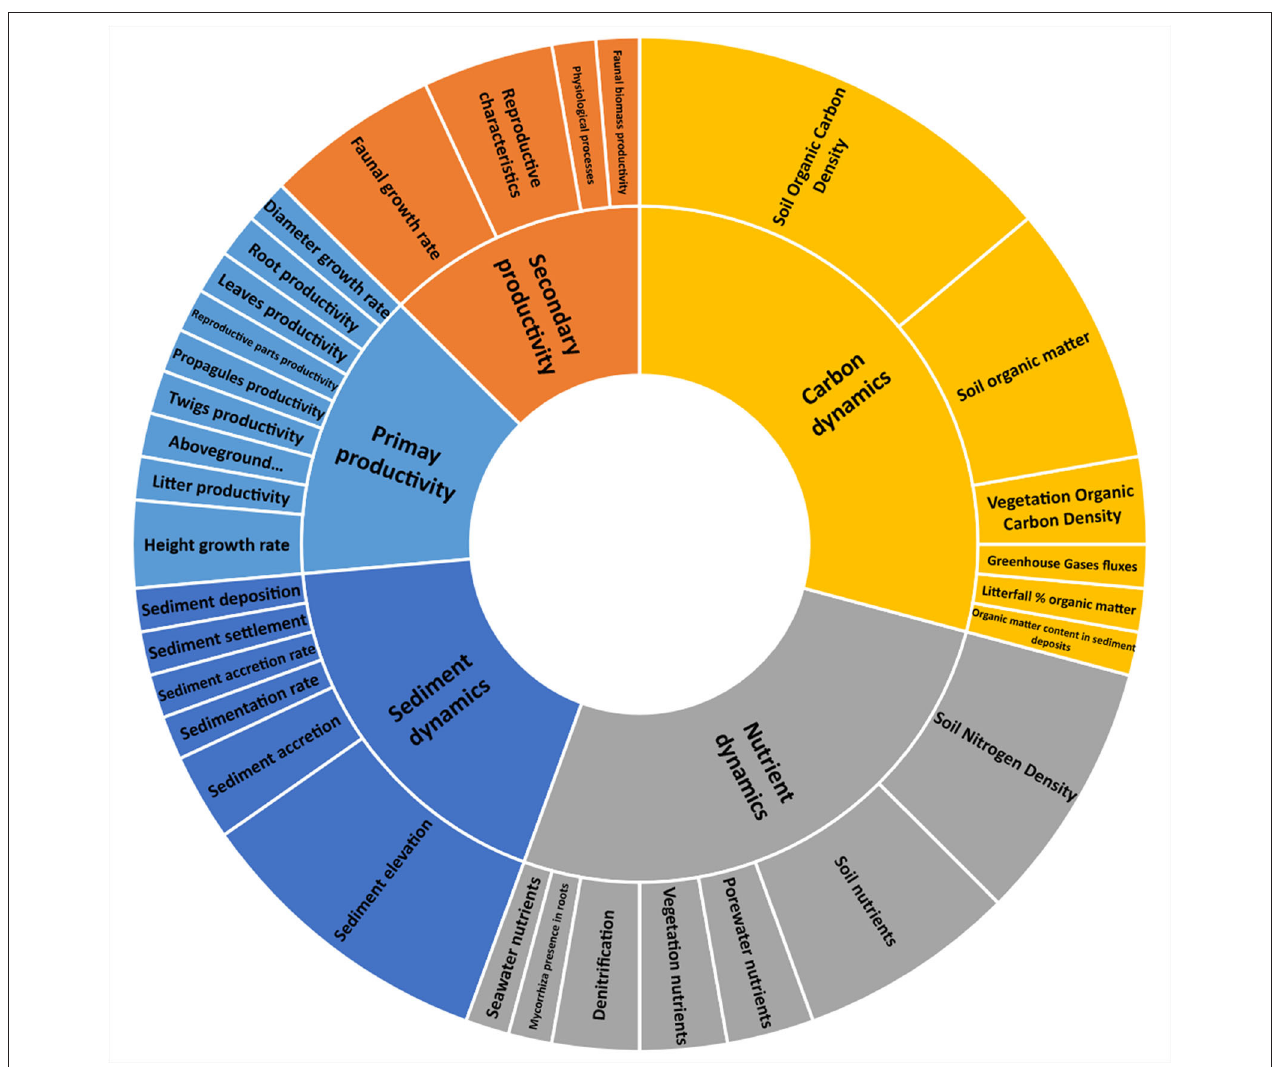
FIGURE 4 | Proportion of indicators (outer ring) nested within their sub-attributes (outer ring) assessed in the scientific